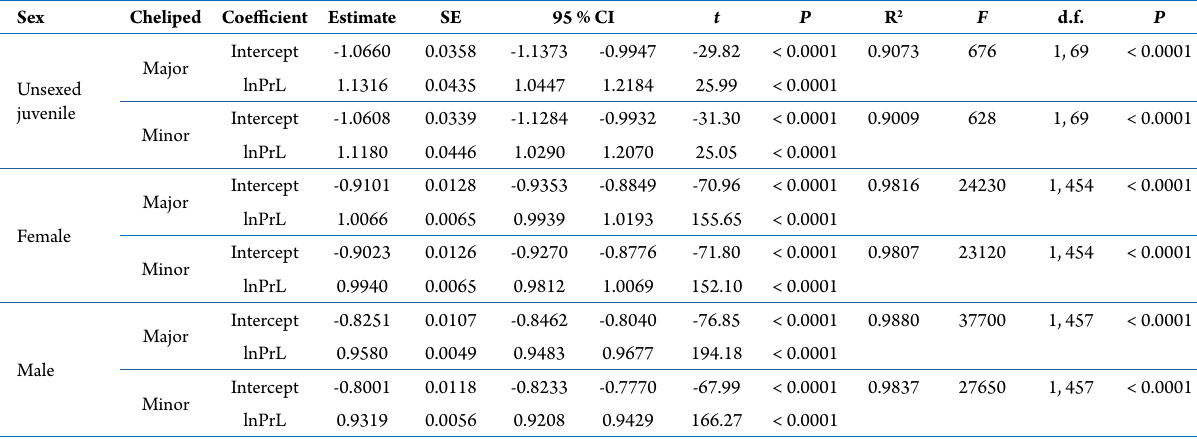
Table 1. Coefficient estimates with standard errors (SE) and their 95 % confidence intervals (CI) of log-transformed allometric growth equations (lnPrW = lna + b lnPrL) to evaluate the relationships between propodus length (PrL) and propodus width (PrW) of major or minor chelipeds of the porcellanid crab Petrolisthes japonicus . The statistical significance of the coefficient estimates and each model was evaluated with t -tests and F -tests,